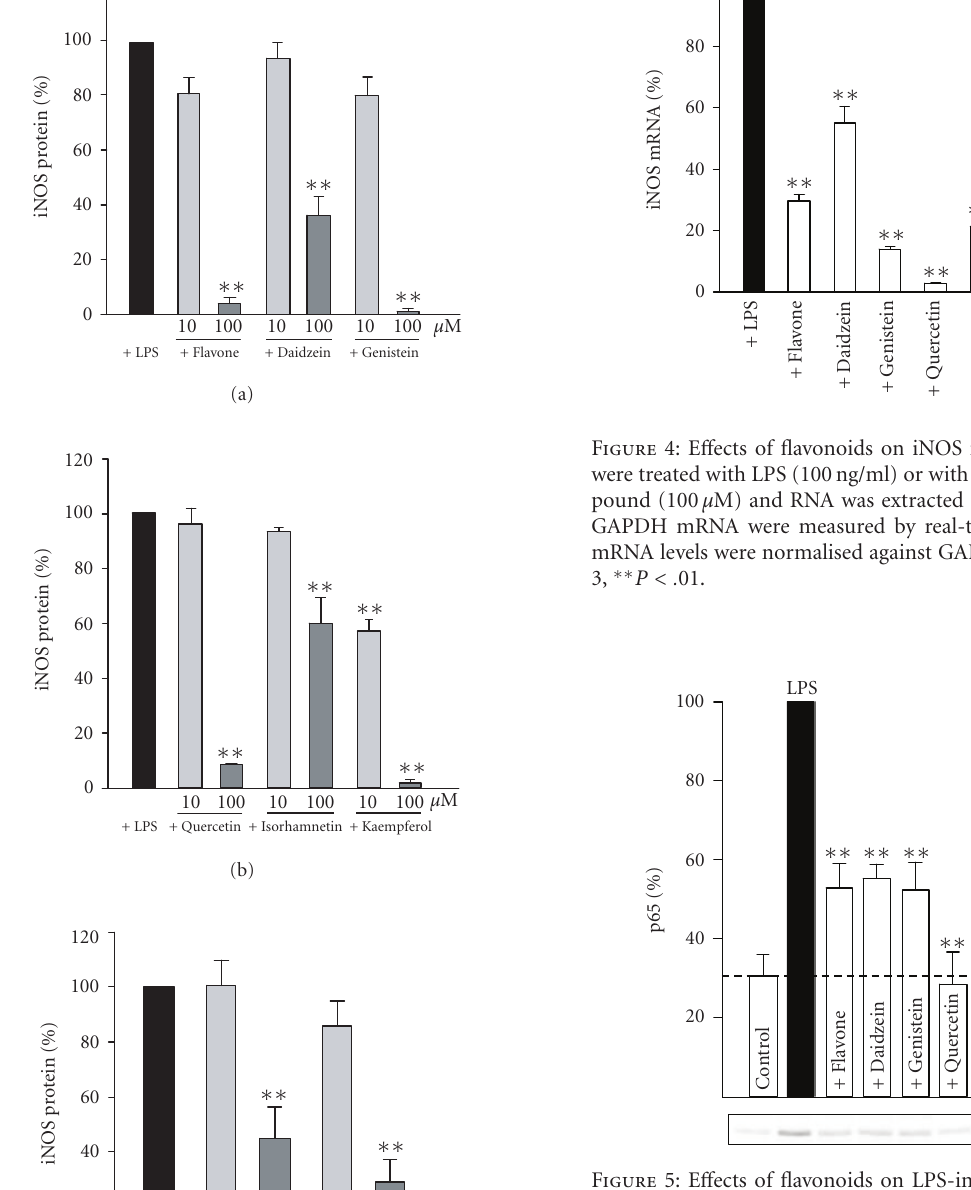
Figure 5: E ff ects of flavonoids on LPS-induced NF- κ B activation determined as nuclear translocation of NF- κ B. J774 cells were in- cubated for 30 minutes with LPS (100ng/ml) or with LPS and the flavonoid (100 μ M), and nuclear proteins were extracted. Western blot was used to detect the p65 subunits of NF- κ B in the nuclear extracts. p65 levels in LPS-treated cells were set at 100% and the other values were related to that. The dotted line represents the nu- clear p65 levels in untreated control cells. Mean + SEM, n = 4 − 6, ∗∗ P < . 01 as compared to LPS-induced level. totally (91% inhibition) inhibited by quercetin. Daidzein, genistein, and kaempferol had a moderate (32%–41% in- hibition) inhibitory e ff ect whereas flavone, isorhamnetin, naringenin, and pelargonidin showed no inhibitory e ff ect on the activation of STAT-1 (see Figure